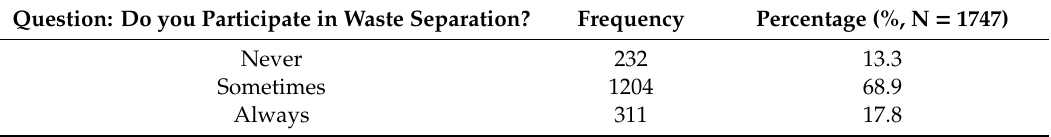
Table 2. College students’ current waste separation